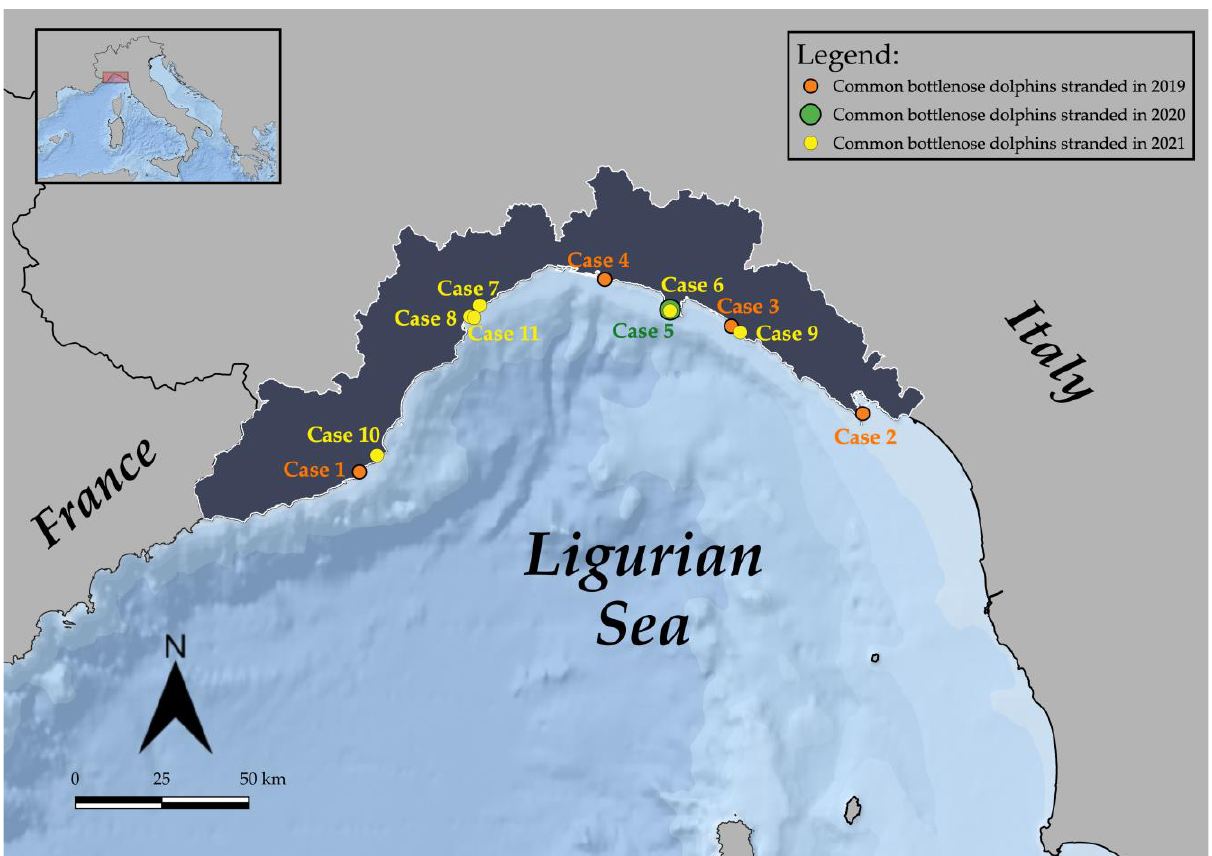
Figure 1. Map of the study area (Ligurian coastline), displaying the stranding locations of the 11 common bottlenose dolphins under study (QGIS Desktop 3.10.5 with GRASS 7.8.2). Table 1. Overview of diagnostic investigations conducted per case. Cases are listed in chronological order; the IZS identification code is also reported for each specimen.